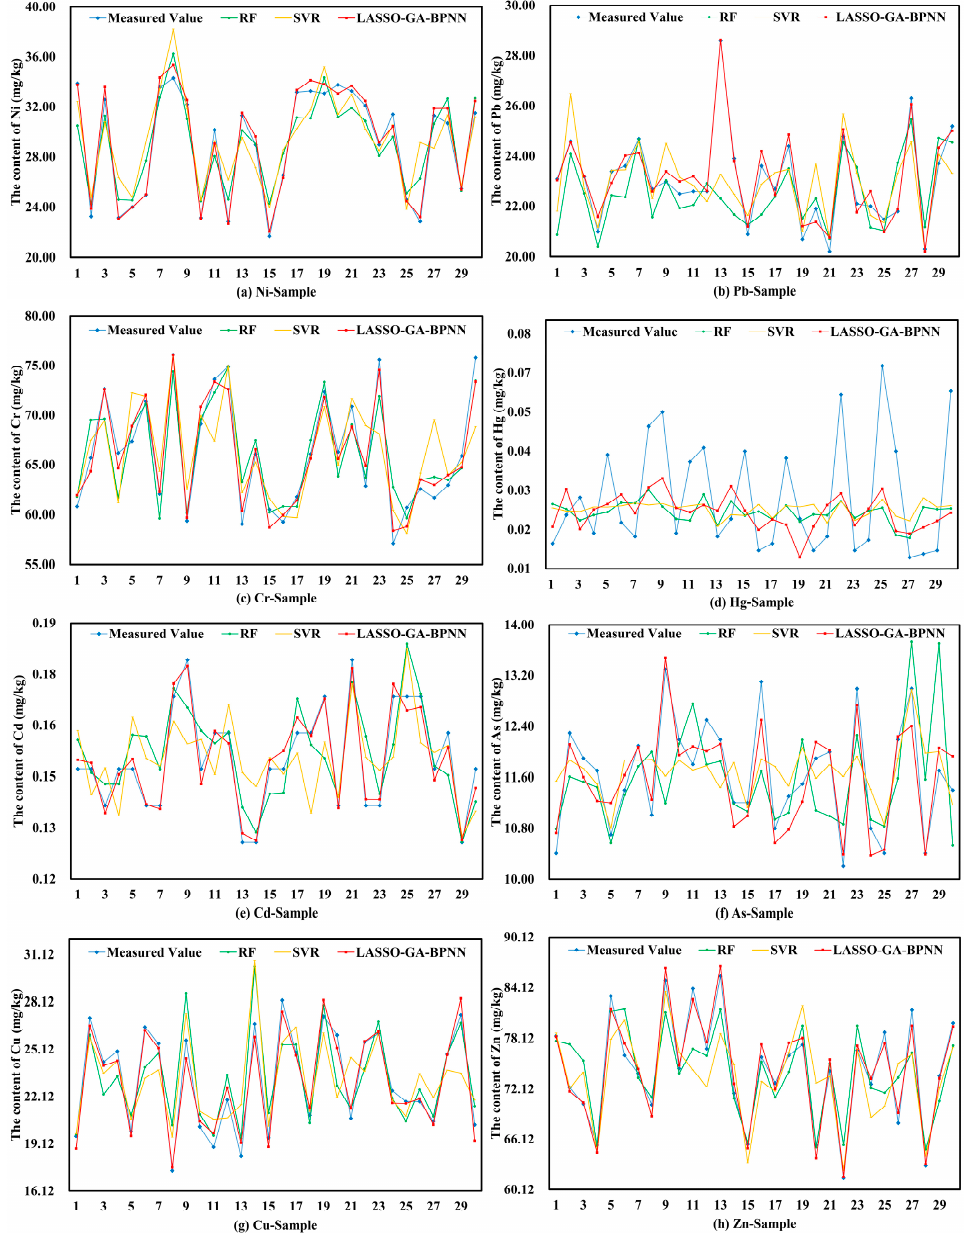
Figure 4. The estimated value and the measured value of the test set (( a – h ) correspond to the elements of Ni, Pb, Cr, Hg, Cd, As, Cu and Zn, respectively; the blue dots are the measured values of every elemental in the soil, and the green, orange, and red dots are the estimated values from the RF, SVR, and LASSO-GA-BPNN models, respectively).